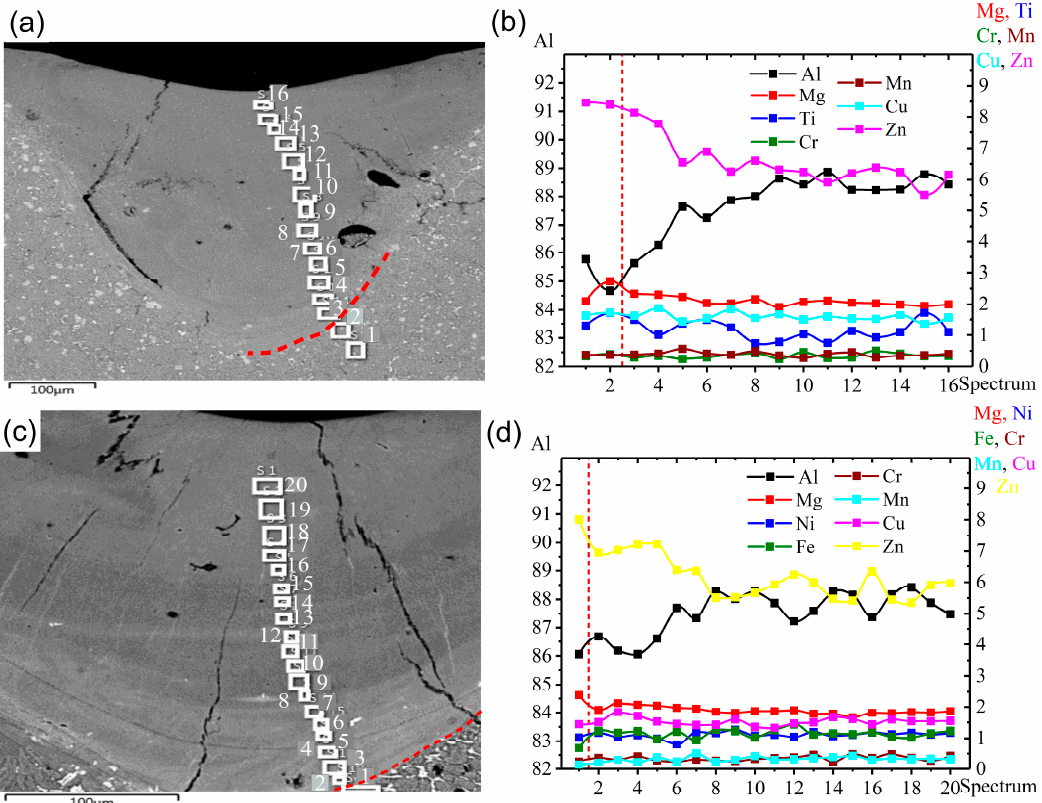
Figure 10. Concentration of elements at different points along the LMZ after homogenization annealing at 460 °C for 3 h: ( a , b ) AA7075-TiB, ( c , d ) AA7075-FeNi.